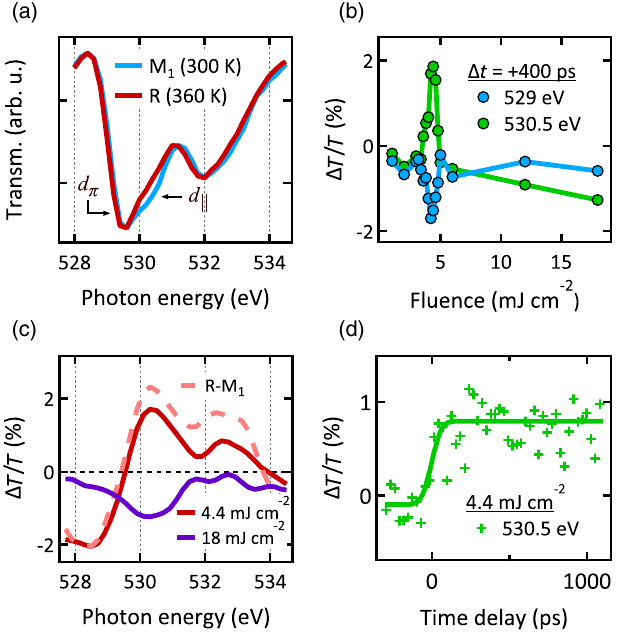
FIG. 3. Simultaneous measurements of the structural and electronic degrees of freedom with time-resolved x-ray absorp- tion spectroscopy. (a) Static, high-resolution x-ray spectra mea- sured at temperatures below and above T c . The absorption peaks observed correspond to the π (cid:2) , d k , and σ (cid:2) bands. (b) Fluence dependence of the π (cid:2) (529 eV, blue) and d k (530.5 eV, green) states. The insulator-metal threshold is found at 3 mJ cm 2 , and a maximum change is observed at 4 . 4 mJ cm 2 . High fluences result in a decrease in signal as the material is heated until it is already in the metallic phase upon excitation. At the largest fluences, a new XAS signal is observed, resulting from dynamics of the metallic phase. (c) Comparison of transient and thermal XAS spectra at the oxygen K -edge. The differential transient spectrum (solid red line) measured at a delay of 400 ps shows an excellent agreement with that obtained from thermal changes (dashed line). The metallic transient response (purple) has a completely different spectrum. (d) The temporal dynamics of the d k (530.5 eV, green) states show changes rising within the 70-ps experimental reso- lution and show no subsequent dynamics. Note that this meas- urement was performed on a different region of the sample, which showed a smaller signal than (a) –